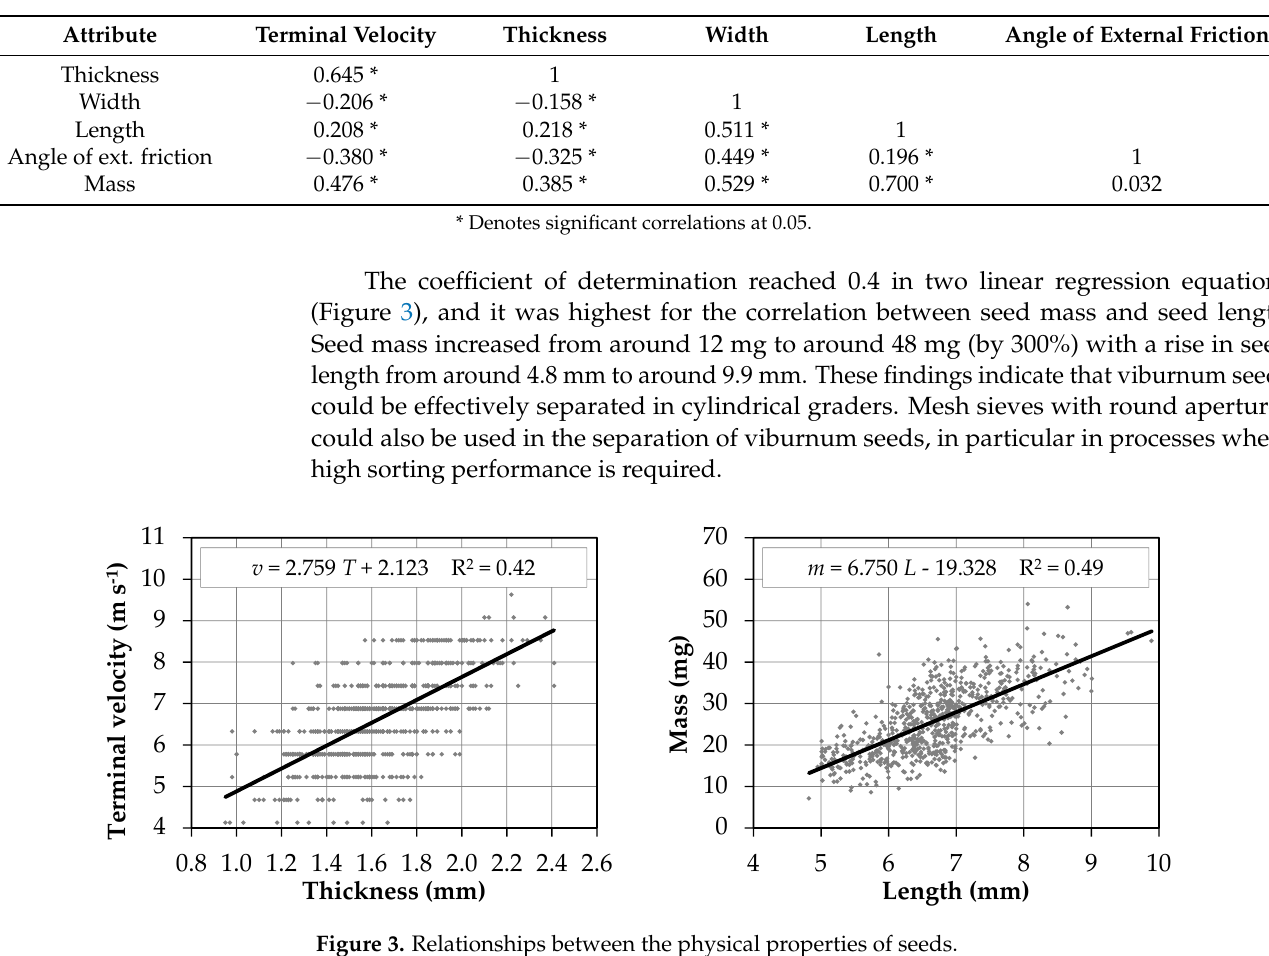
Figure 3. Relationships between the physical properties of seeds.